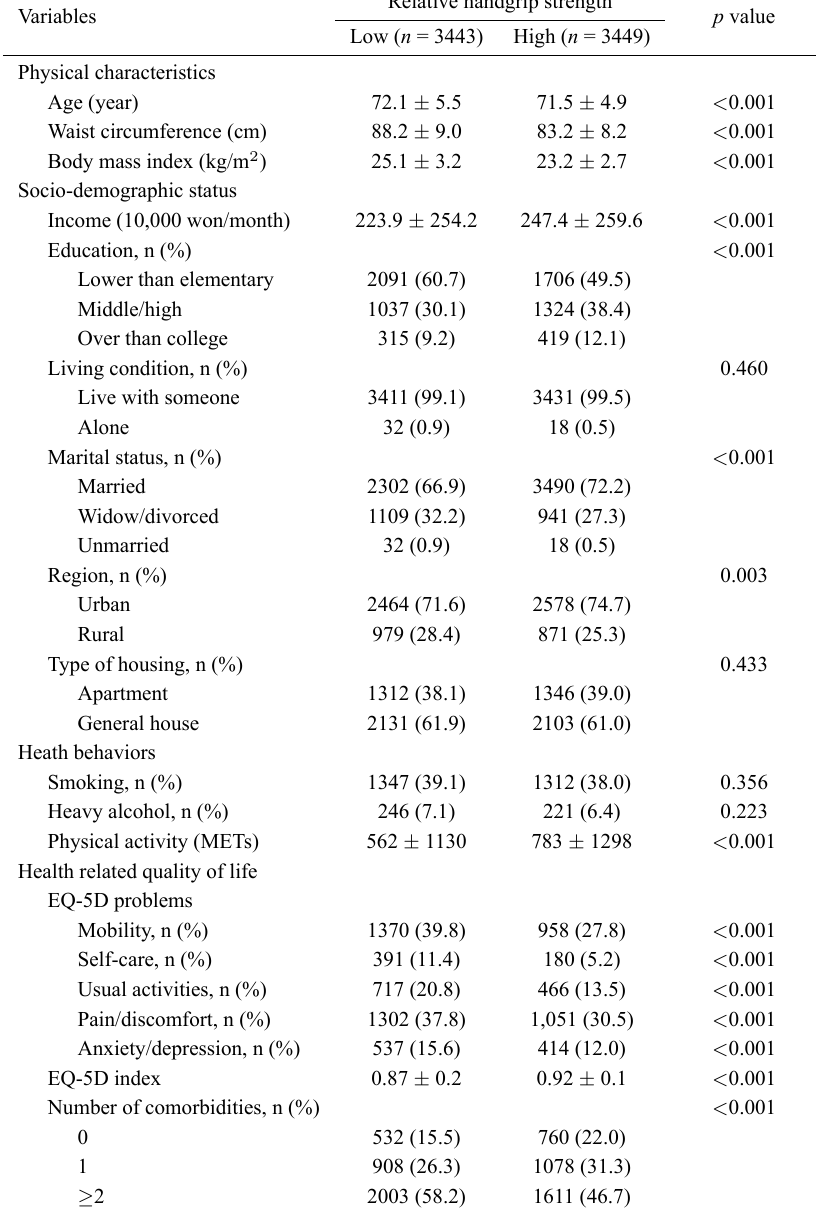
Table 3. Baseline characteristics according to relative handgrip